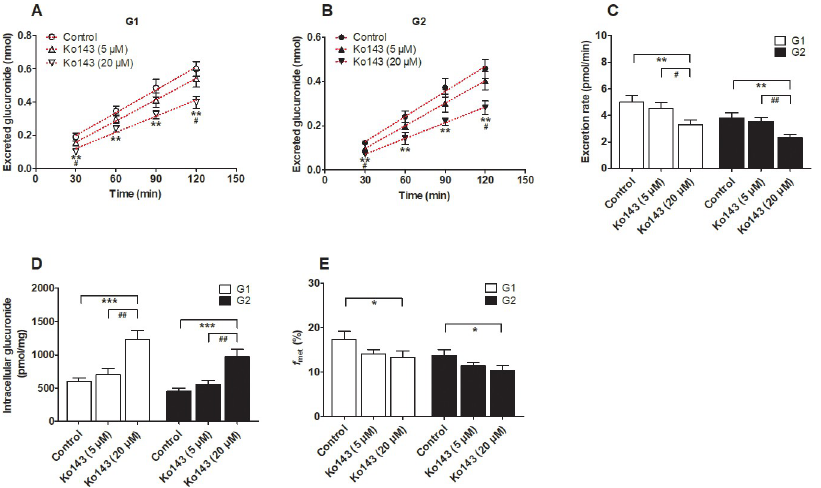
Fig 5. Effects of Ko143 on the formation and efflux excretion of demethoxycurcumin- O -glucuronides in HeLa1A1 cells. (A) Effects of Ko143 (5 and 20 μ M) on the accumulation of demethoxycurcumin- O -glucuronides (G1) in extracellular medium; (B) Effects of Ko143 (5 and 20 μ M) on demethoxycurcumin- O -glucuronides (G2) excretion in extracellular solutions; (C) Effects of Ko143 (5 and 20 μ M) on the efflux excretion rates of G1 and G2; (D) Effects of Ko143 (5 and 20 μ M) on the intracellular G1 and G2 levels; (E) Effects of Ko143 (5 and 20 μ M) on the fraction metabolized ( f met ) of demethoxycurcumin; All experiments were performed in triplicate (n = 3). Data were presented as mean ± SD (n = 3). � , # p < 0.05, �� , ## p < 0.01 and ��� , ### p < 0.001 compared with that of control group of G1 or G2, respectively.